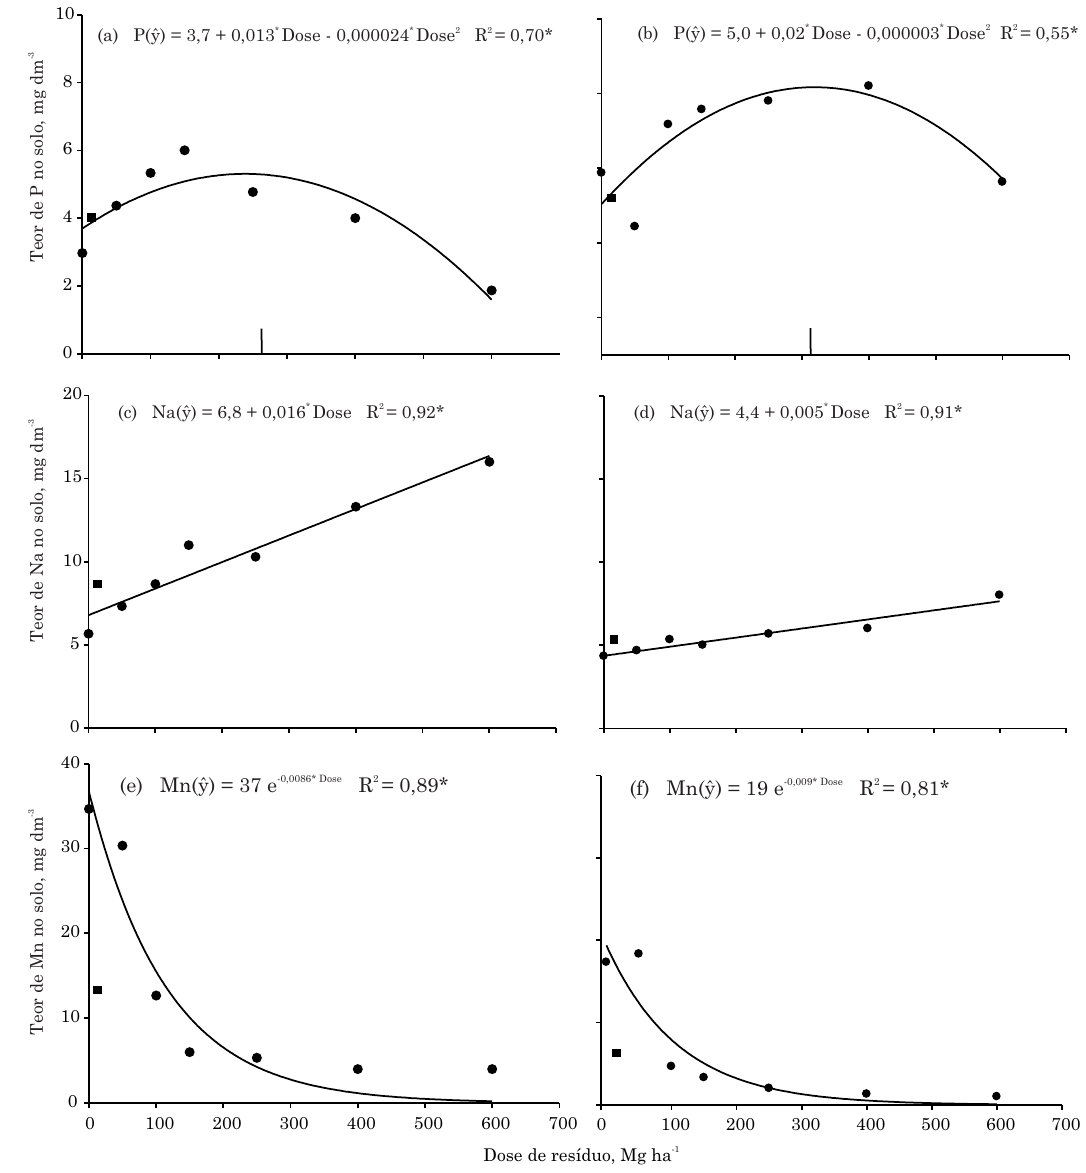
Figura 2. Teores de P no solo (Mehlich-1) (a, b), Na (c, d) e Mn (e, f) em função de doses de resíduo de reciclagem de papel ( lllll ) e com aplicação de calcário ( nnnnn ) (amostragens: abril de 2010, na esquerda, e abril de 2011, na direita). * Significativo a 5 % pelo teste t. (|) máxima eficiência